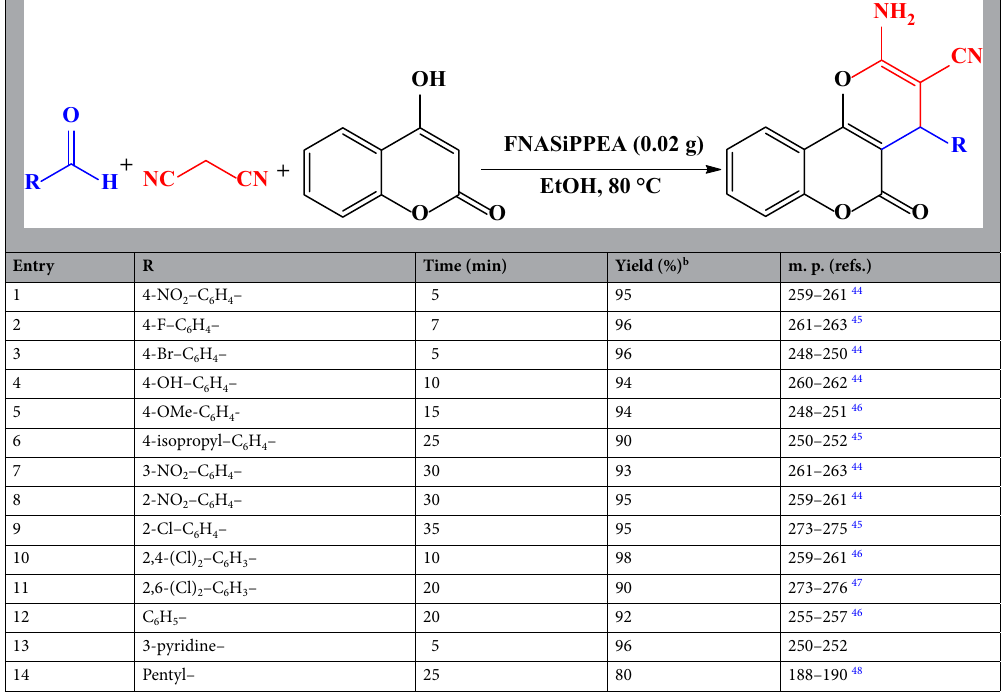
Table 3. FNASiPPEA catalyzed the synthesis of DHPC. a a Conditions: aldehyde (1 mmol), 4-hydroxycoumarin (1 mmol), malononitrile (1.5 mmol), 80 °C, EtOH Solvent, catalyst (0.02 g) b Isolated